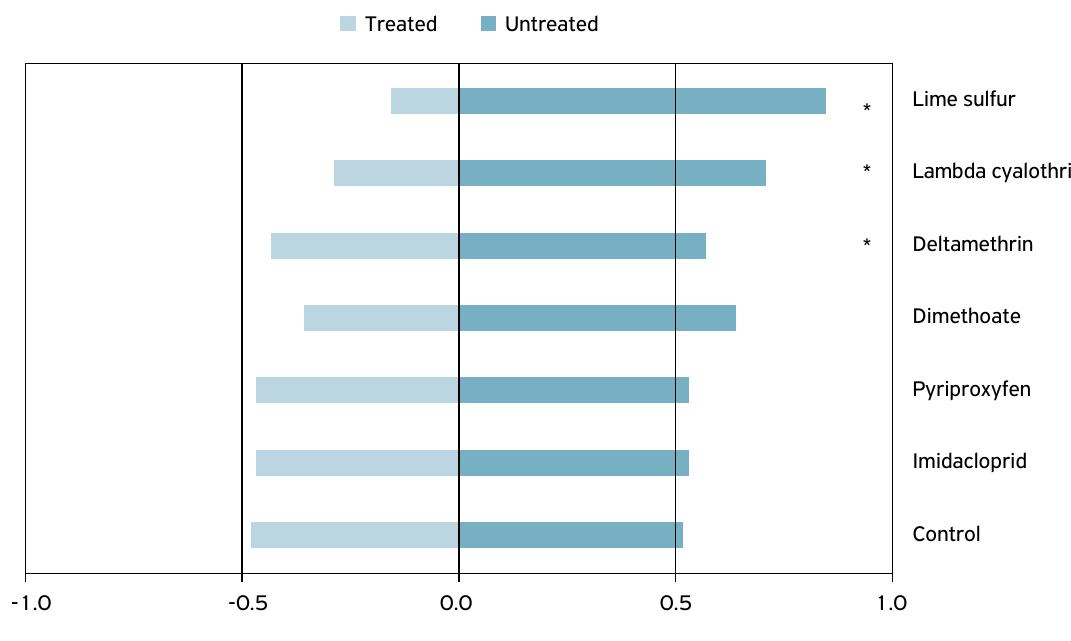
Figure 4. Oviposition behavior of Panonychus citri on discontinuous pesticide residues, 48 h after infestation.